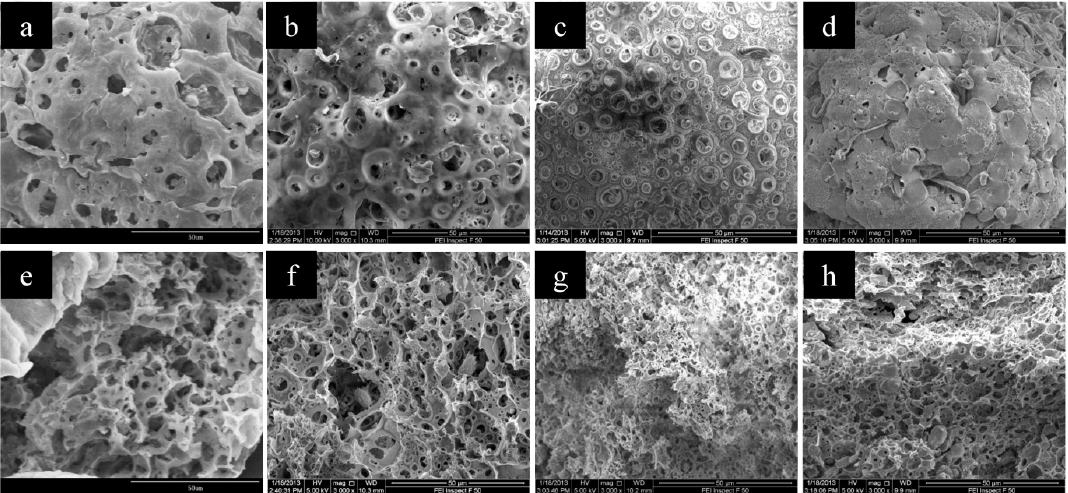
Figure 9. The SEM images of CMC/CA microspheres fabricated with Cu(II) content of 25mM ( a , e ), 50mM ( b , f ), 100mM ( c , g ), 200mM ( d , h ) in the outer aqueous solution. Images (a–d) are the surface images while (e–h) are the cross-section images of the CMC/CA microspheres.